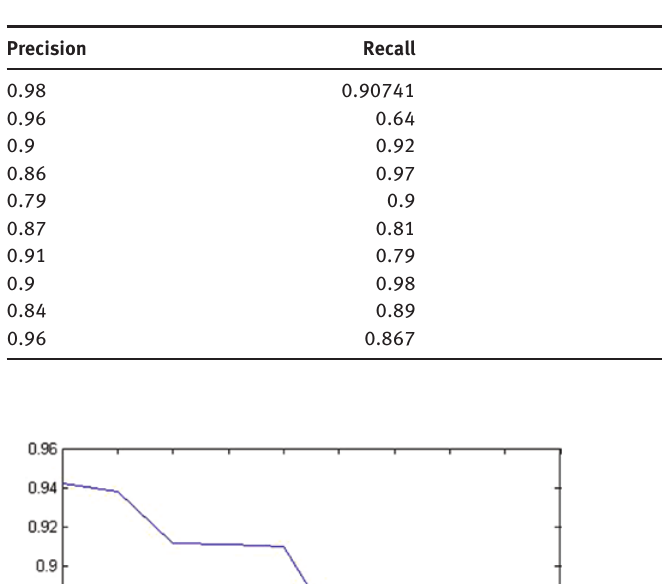
Table 1: Evaluation Metrics.